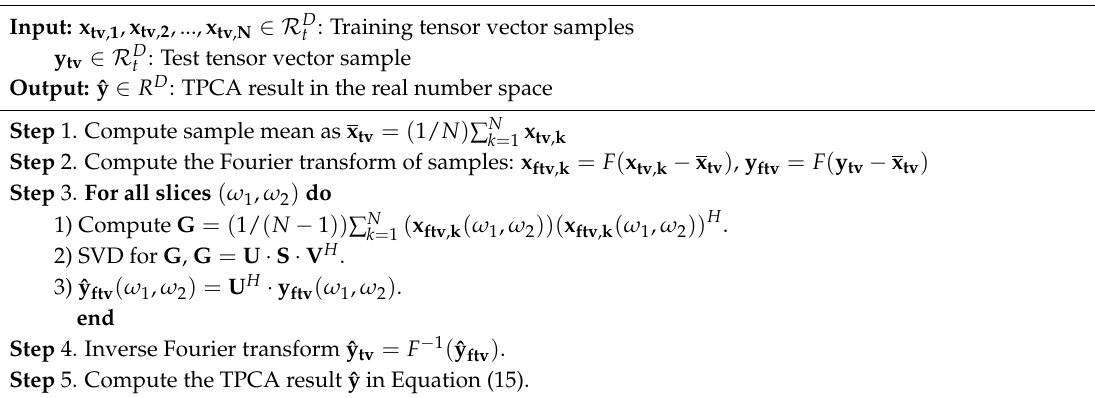
Algorithm 1: Fast TPCA computation via Fourier